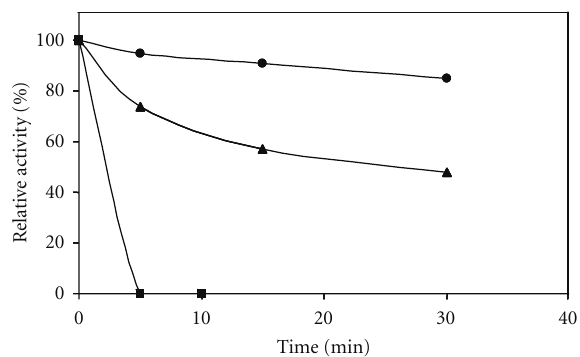
Figure 3: Temperature stability of the AMP-dependent ACS Mthe 1194. ( • ) Incubation at 55 ◦ C, ( (cid:4) ) incubation at 75 ◦ C, and ( (cid:3) ) incubation at 92 ◦ C. Enzyme activity was measured in the NADH consumption assay with auxiliary enzymes at 55 ◦